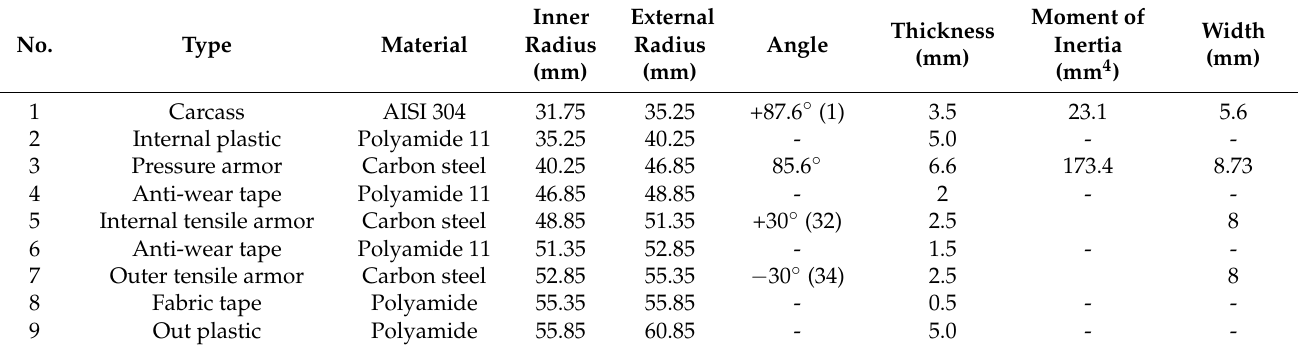
Table 2. Geometric parameters of flexible risers tested.